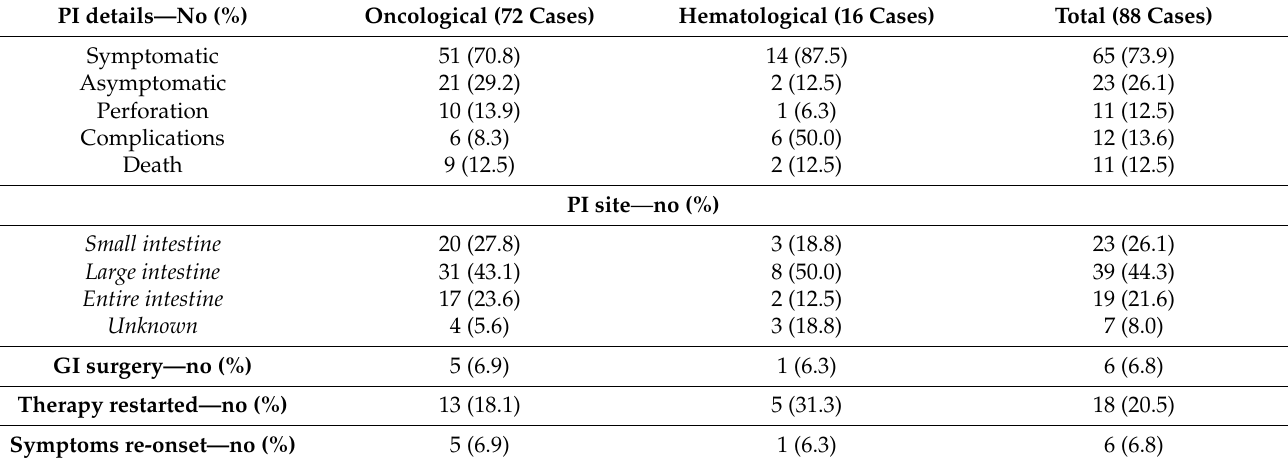
Figure 5. Overview of pneumatosis intestinalis management. Table 3. Clinical presentation and outcome of PI.